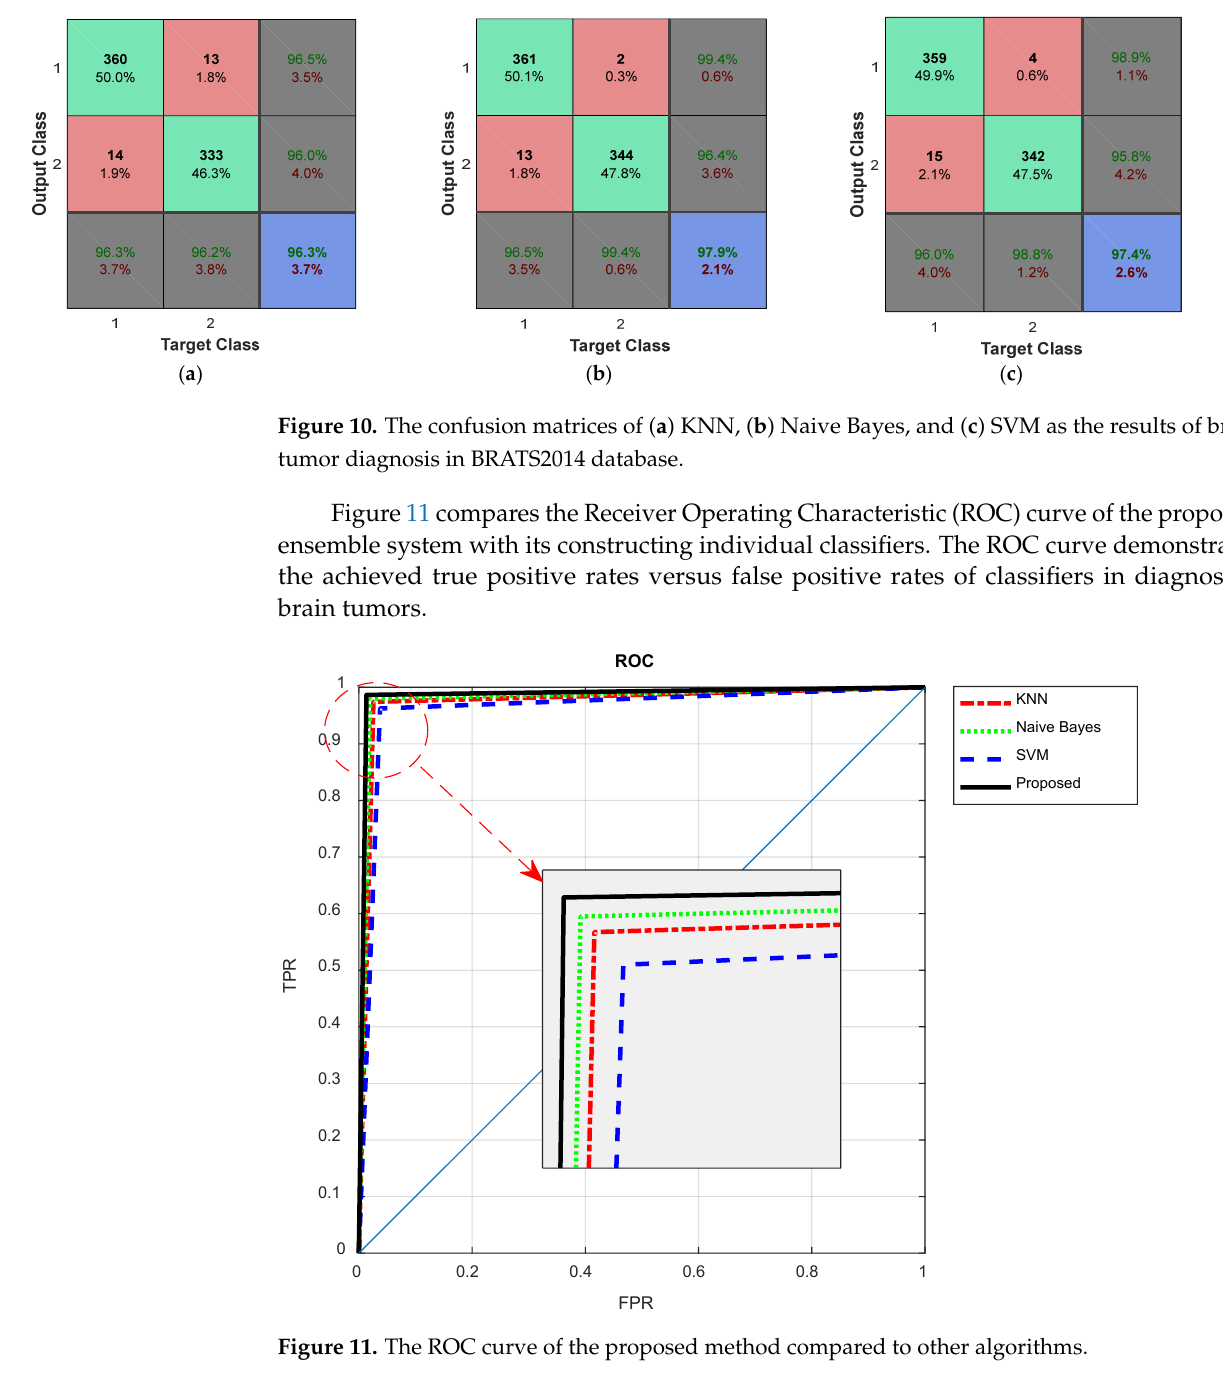
Figure 9. The confusion matrix of the proposed method as a result of brain tumor diagnosis in BRATS2014 database.